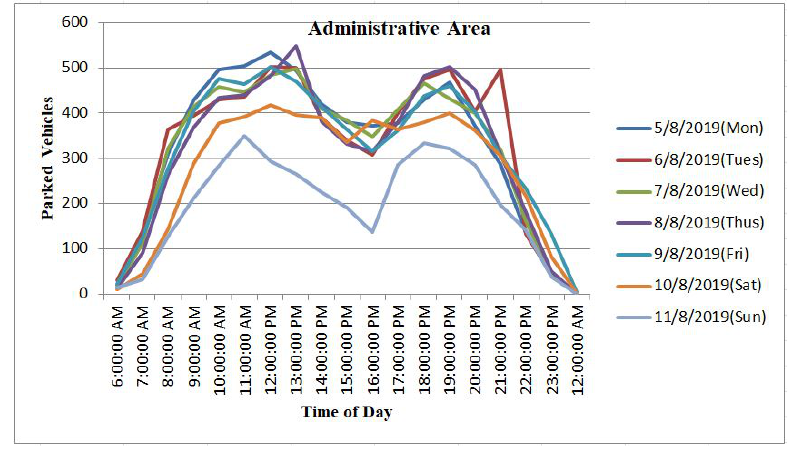
Figure 8. Administrative area